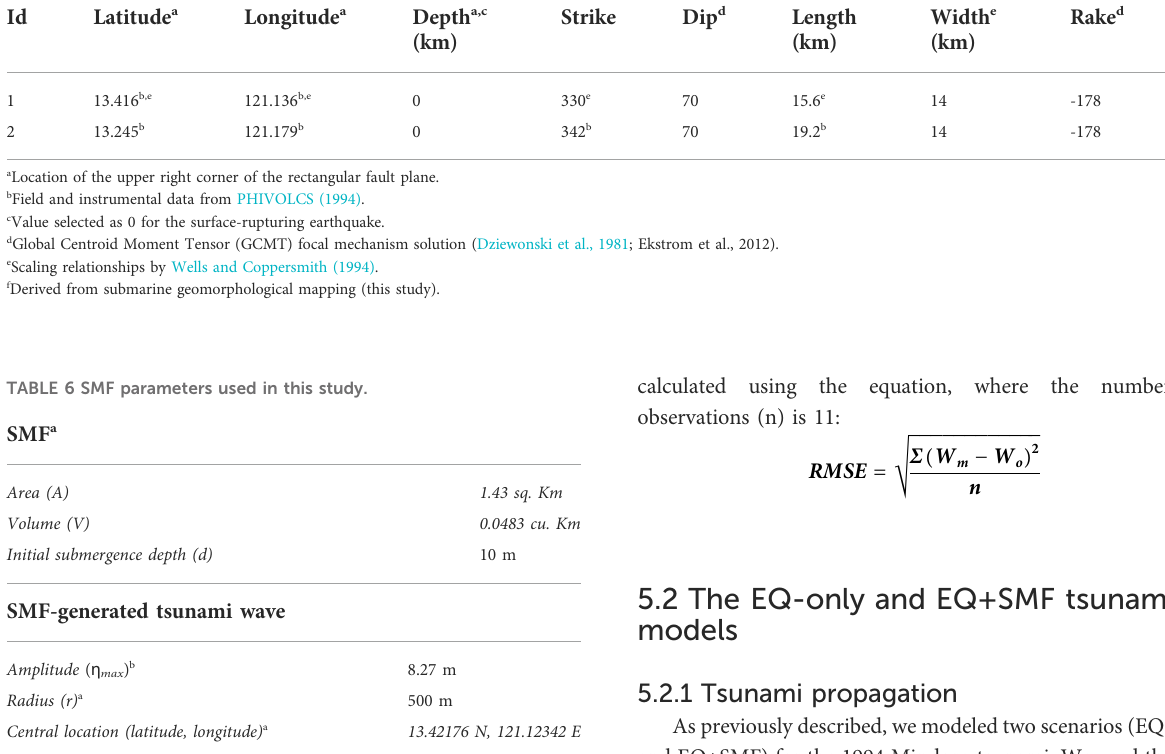
TABLE 5 Fault parameters for the Aglubang River Fault as used for the earthquake source mechanism. The two sub-faults are based on the geomorphologicalexpressionoftheoffshoreextension(thisstudy),andthemappedonshorerupture(PHIVOLCS,1994)aslabeledinFigures6,7. Id